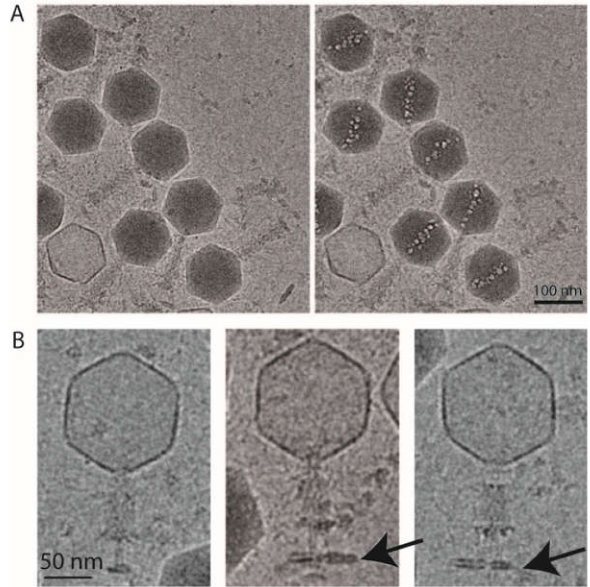
Figure 4. Cryo-electron microscopy of phAPEC6. ( A ) Low-dose and high-dose cryo-electron microscopy images of phAPEC6 demonstrate the presence of an inner body. ( B ) Cryo-electron microscopy images of the contracted form of phAPEC6. The capsid has released all the DNA, the tail is contracted and the presence of a little piece of host cell membrane is visible